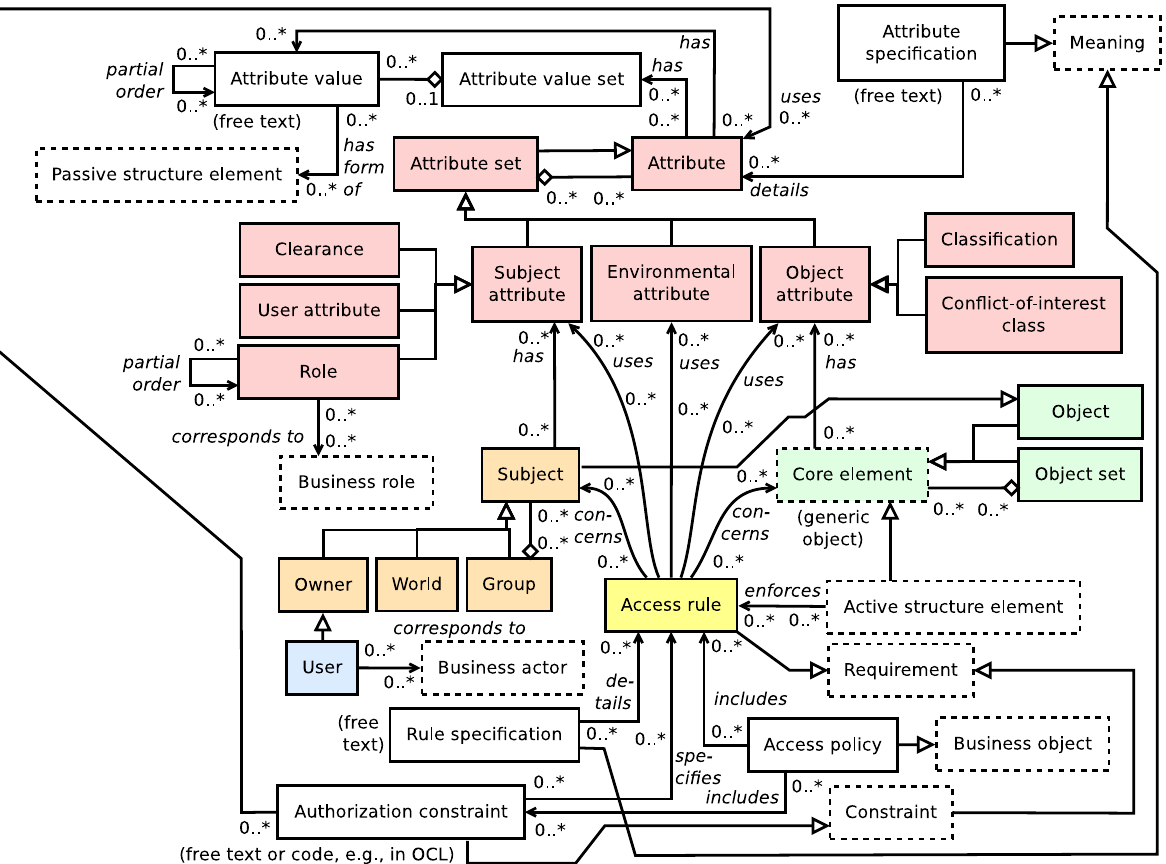
Figure 4. Proposed unified metamodel for modeling authorization. The dashed entities are defined by ArchiMate